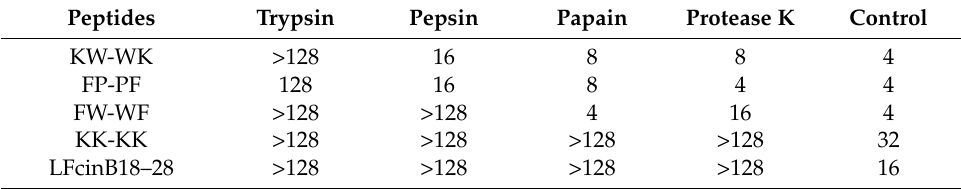
Table 5. MIC values of antimicrobial peptides in the presence of proteolytic enzymes.